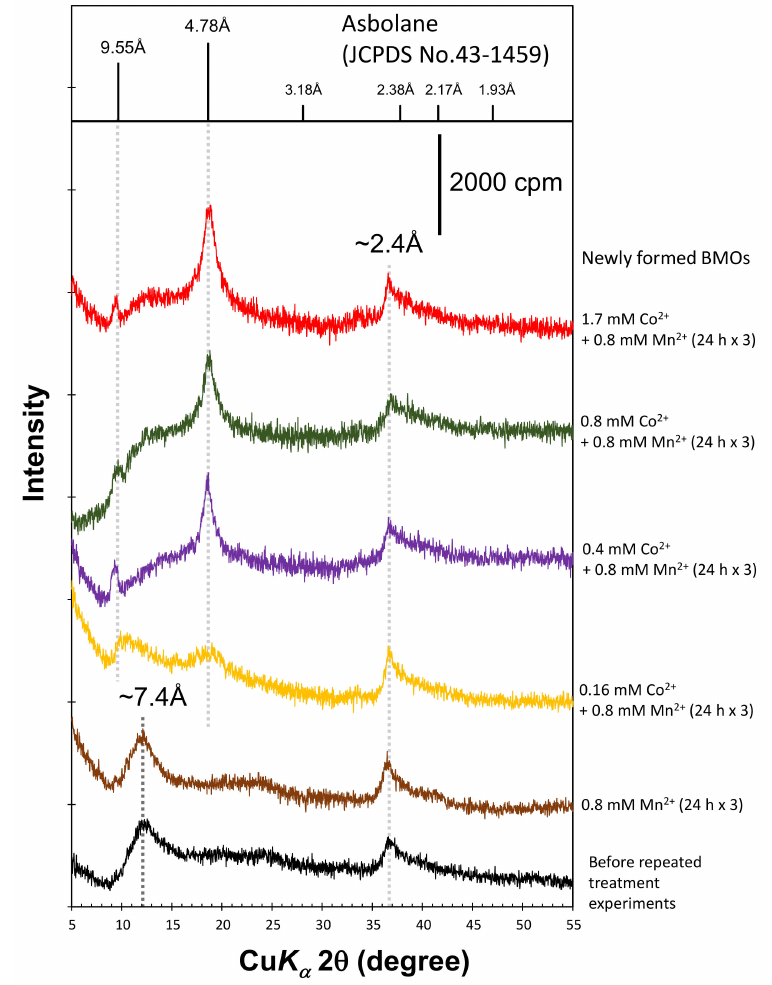
Figure 6. Powder X-ray diffraction patterns of newly formed biogenic manganese oxides (BMOs; 1 mM as Mn) before and after repeated treatment experiments in Co 2+ (0–1.7 mM) solutions with 0.8 mM exogenous Mn 2+ under aerobic conditions at pH 7.0 (100 mM HEPES